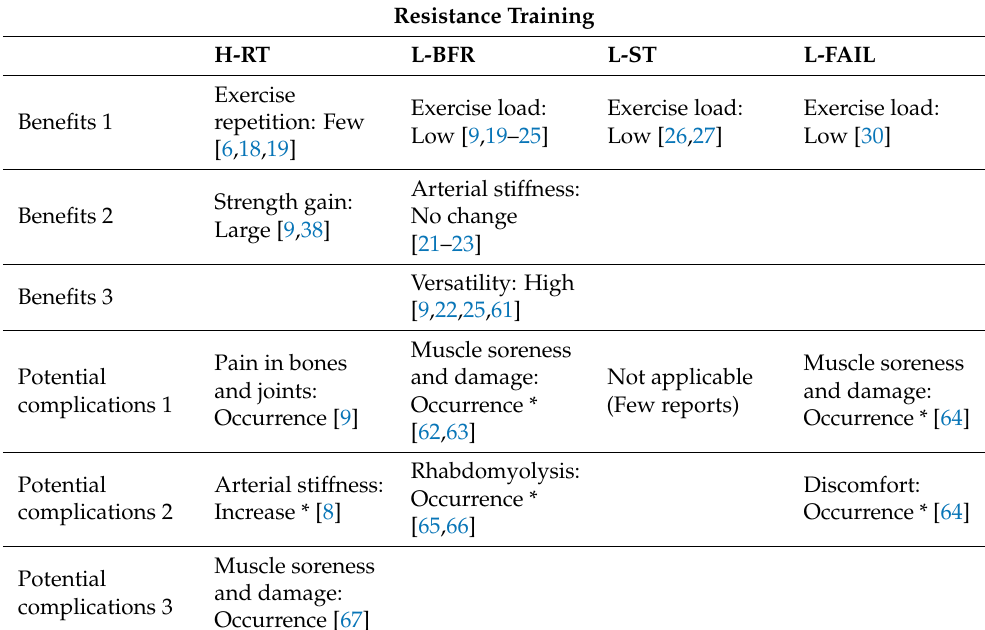
Table 3. Benefits and potential complications of different resistance training modes in older